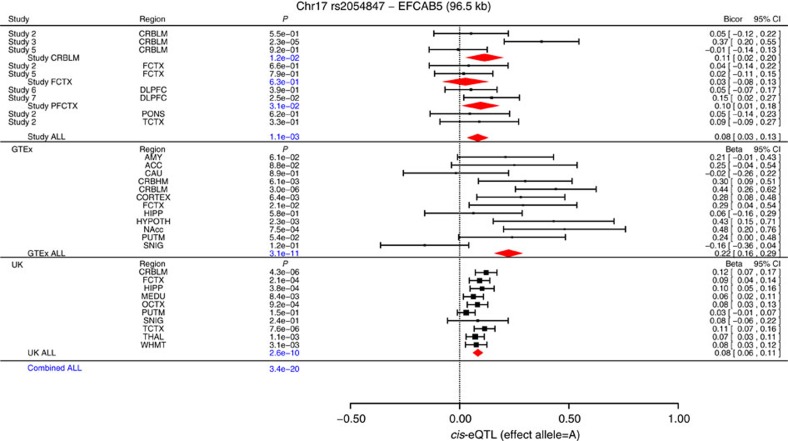
cis-eQTL study across 19 brain regions for the leading SNP in 17q11.The meta-analysis forest plot displays the significant cis-eQTL results for the leading SNP rs2054847 and expression levels of gene EFCAB5, by combining three panels of study results (N=3,943 brain tissues across 19 regions). We display study name, brain region and test statistics including P value, 95% confidence interval (CI) and effect size [95% CI]. The top panel reports a robust correlation coefficient (biweight midcorrelation, bicor). The remaining panels report the beta coefficient value (slopes) of linear regression models between a test allele and gene expression levels. The effect sizes are with respect to minor allele counts. The top panel reports cis-eQTL findings for 1,705 brain tissues across five brain regions from the individuals of our GWAS. Meta-analysis was used to combine individual results from CRBLM into a single estimate, Meta CRBLM. Similarly, we defined meta-analysis results for the frontal cortex (Meta FCTX) and prefrontal cortex (Meta PFCTX). Fixed-effects meta-analysis was used to combine Meta CRBLM, Meta FCTX and Meta PFCTX P values into the meta-analysis P value (Study ALL). The middle panel reports the results from the 1,007 brain tissues across 12 regions from the GTEx project. The fixed-effect model was used to combine GTEx P values into an overall P value denoted GTEx ALL. The lower panel reports the cis-eQTL results evaluated in up to 1,231 brain tissue samples across 10 regions, from the BRAINEAC database. The average across all available regions in the BRAINEAC data based is presented in (UK ALL). The Combined ALL P value was calculated by combining the Study ALL, GTEx ALL and UK ALL values using Stouffer's Z score approach. All the cis-eQTL models assumed used an additive allele coding of the SNP. ACC, anterior cingulate cortex; AMY, amygdala; CAU, caudate basal ganglia; CORTEX, cortex; CRBHM, cerebellar hemisphere; CRBLM, cerebellum; DLPFX, dorsolateral prefrontal cortex; FCTX, frontal cortex; HIPP, hippocampus; HYPOTH, hypothalamus; MEDU, medulla; NAcc, nucleus accumbens; OCTX, occipital cortex; PONS, pons; PUTM, putamen; SNIG, substantia nigra; TCTX, temporal cortex; THAL, thalamus; WHMT, intralobular white matter.